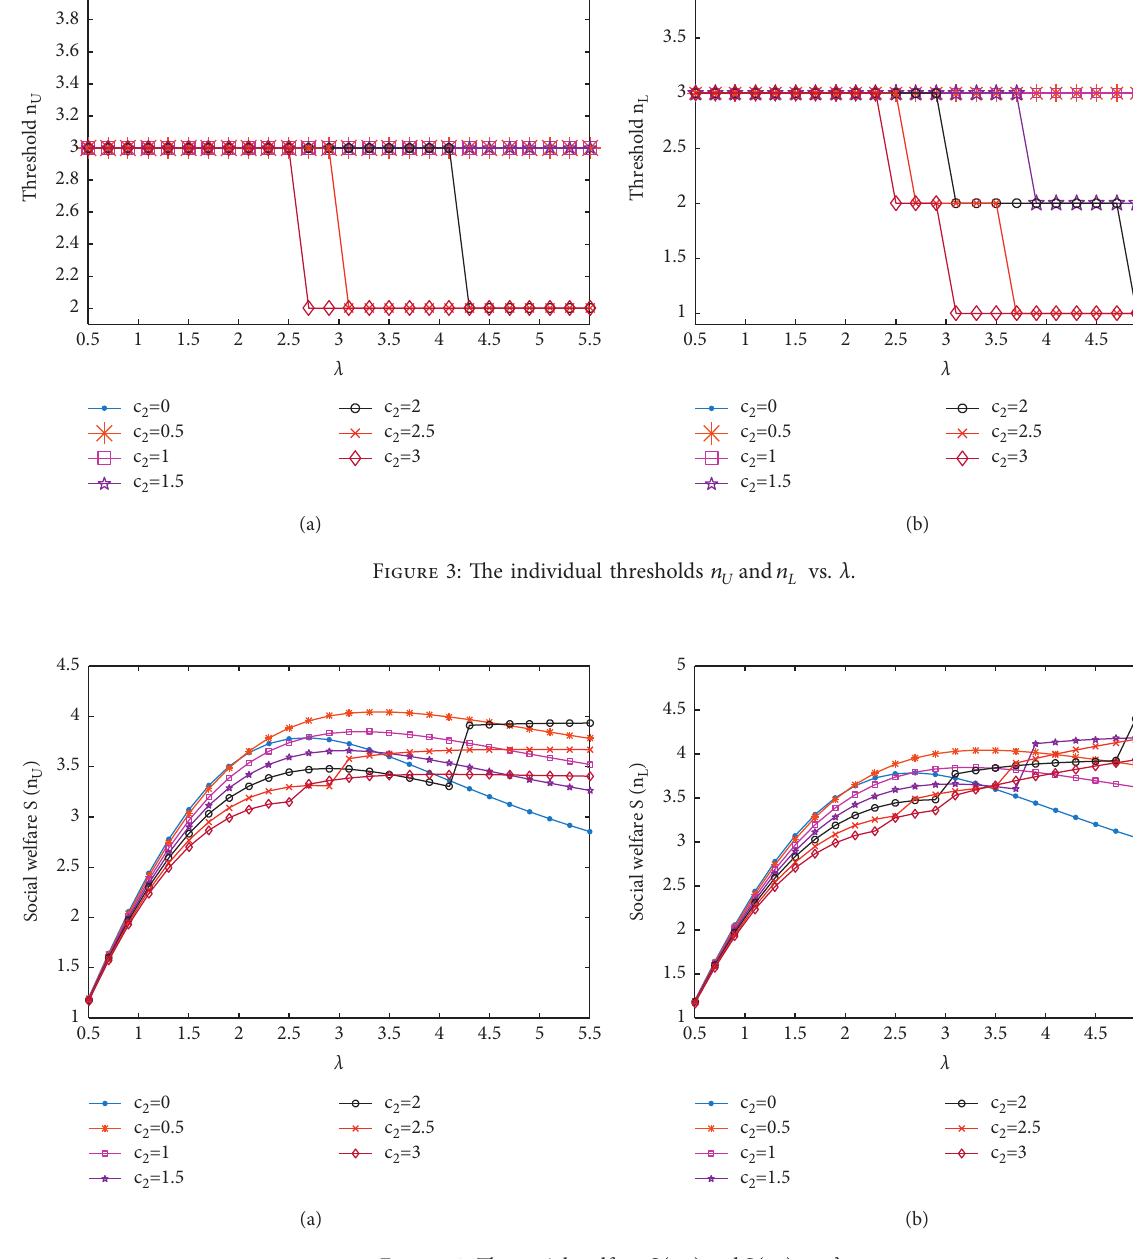
) and S ( n ) vs. λ U L